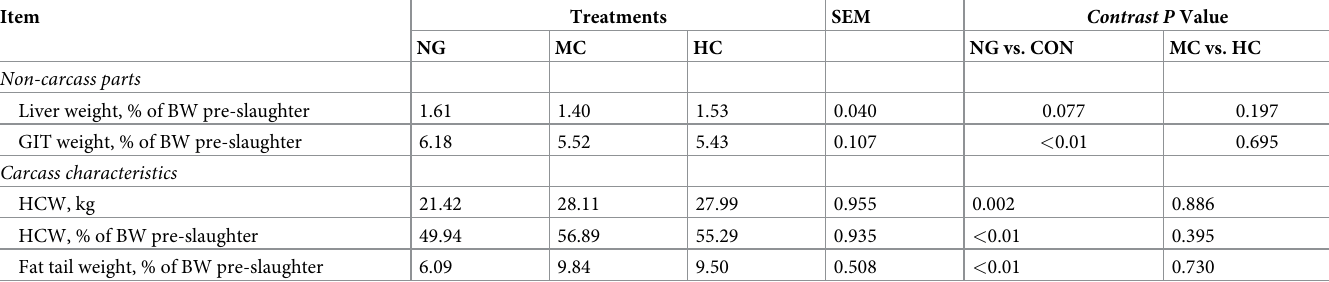
BW = body weight, NG = nomadic-grazing system, MC = medium concentrate-based diet, HC = high concentrate-based diet, CON = concentrate-based diet including both, MC and HC), EBW = empty body weight, GIT = gastrointestinal tract (stomach, small intestine, and large intestine), HCW = hot carcass weight, SEM = standard error of the